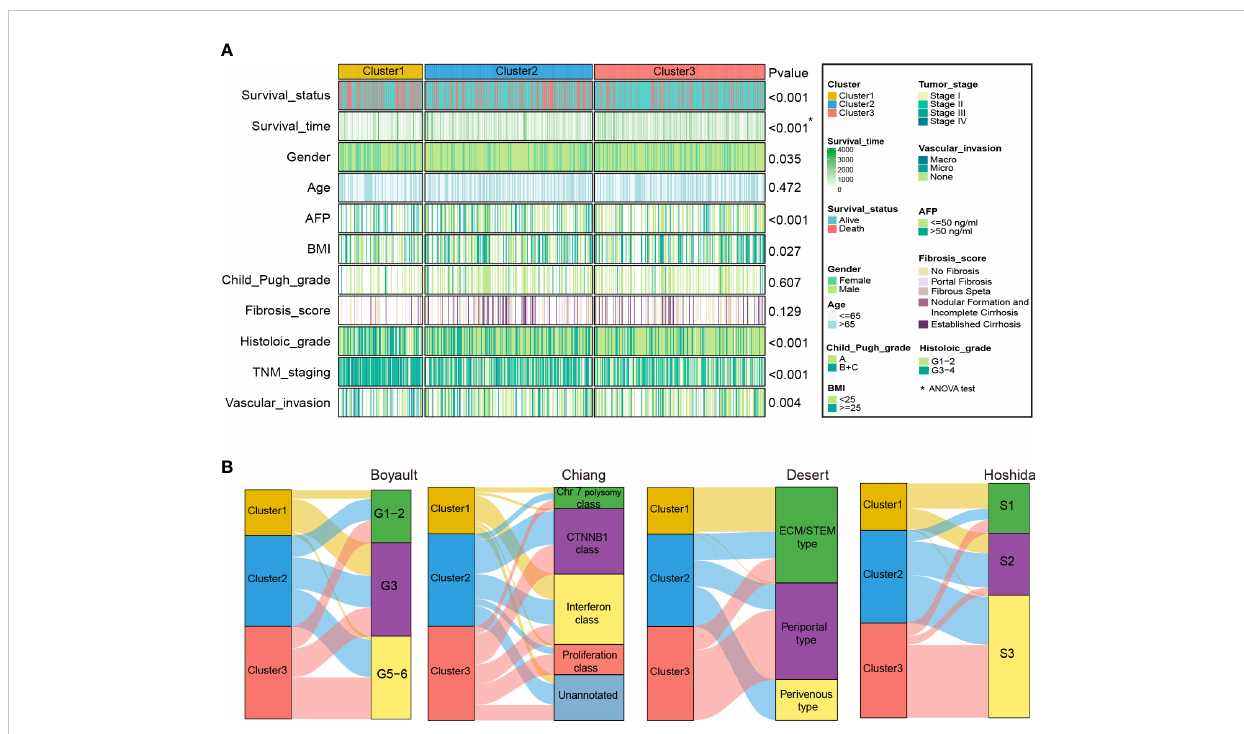
FIGURE 4 Clinical characteristics of zonation marker-associated HCC subclasses in the RNA-seq cohort. (A) Difference of clinical characteristics among the three clusters in the RNA-seq cohort by chi-square test (The comparison of survival time among the three clusters by ANOVA). (B) Correlation of the three clusters with HCC subclasses published previously in RNA-seq cohort by chi-square